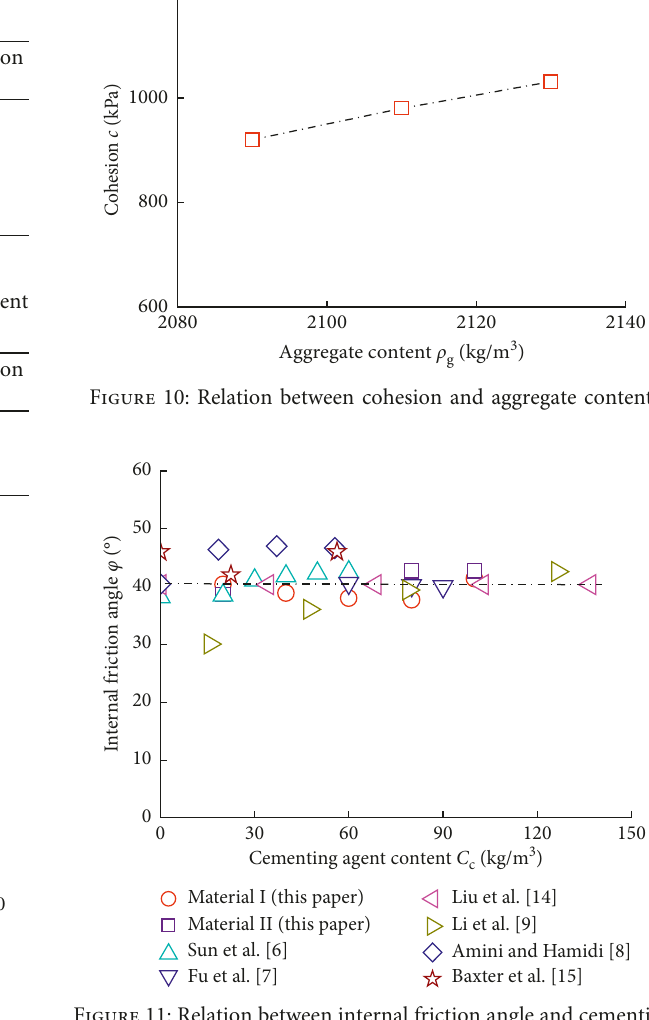
Figure 11: Relation between internal friction angle and cementing agent